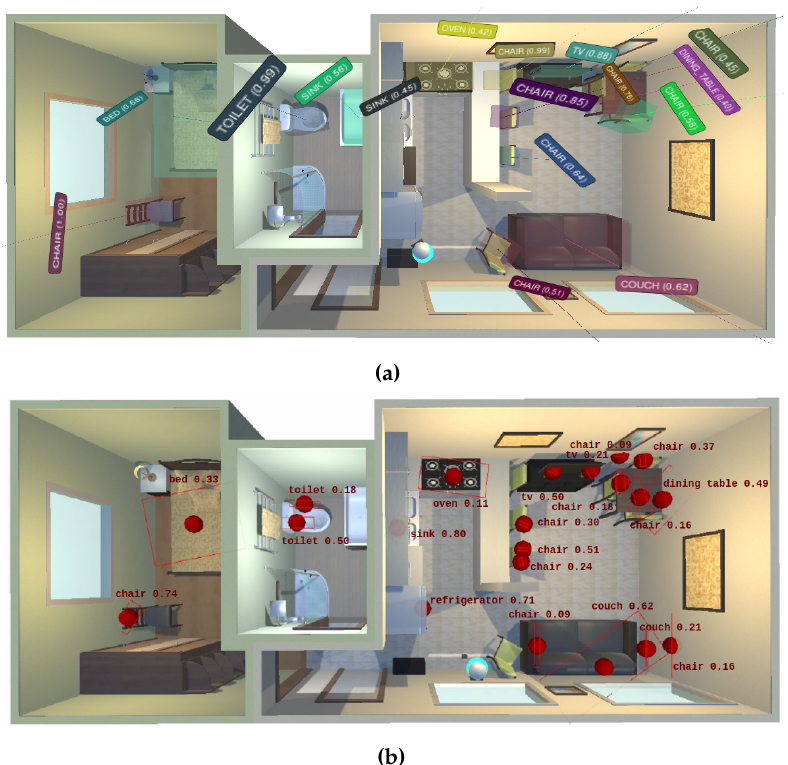
Figure 6. Semantic maps built by each evaluated method in the environment House 20 from the Robot@VirtualHome ecosystem. ( a ) LTC-Mapping ; ( b ) Dengler et al.